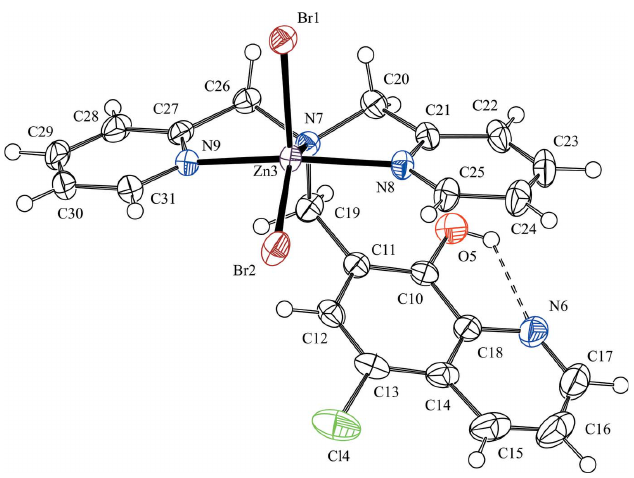
Figure 1 The molecular structure of the title compound, with atom